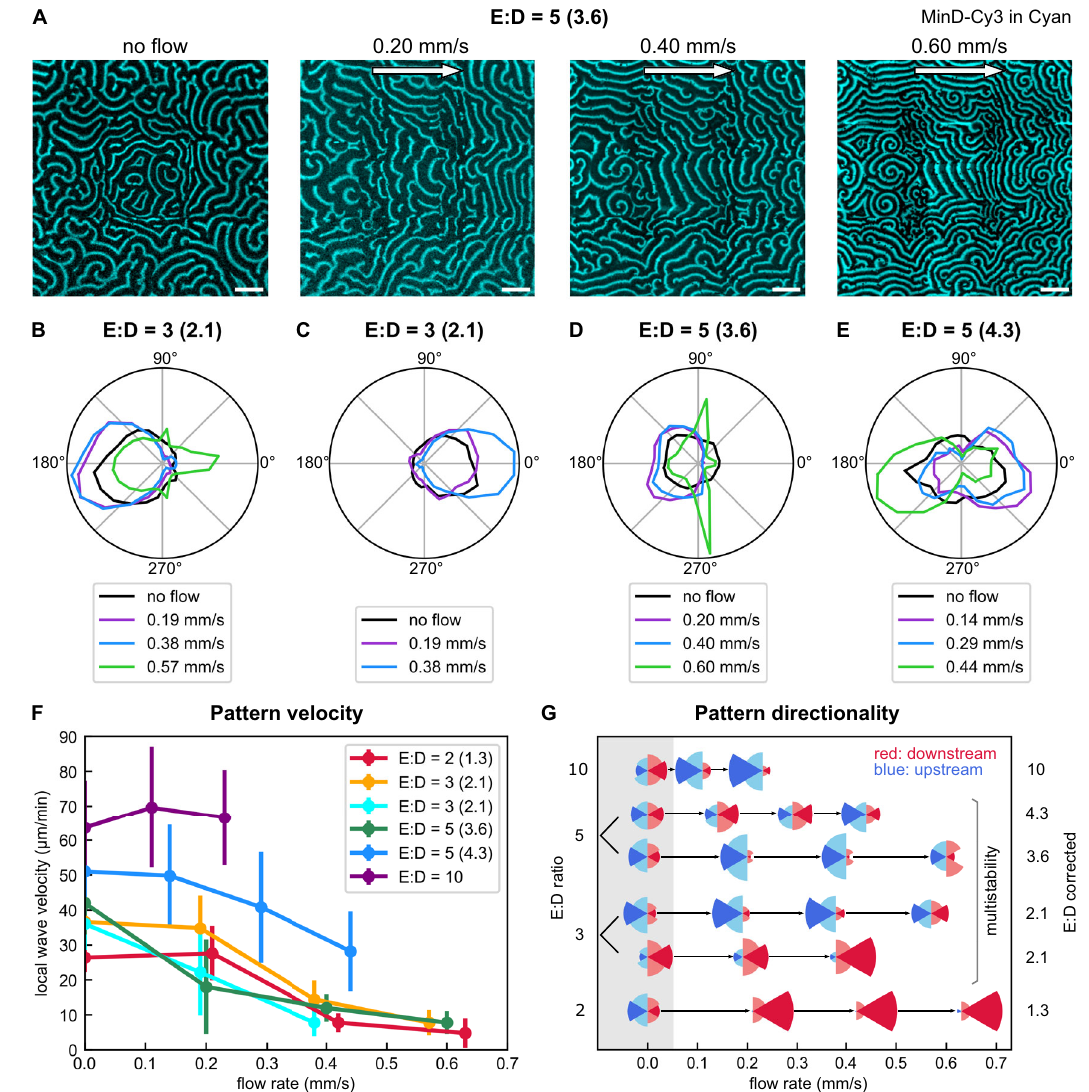
Fig. 4 |Experimentaldatashowing howMinpatternsrespondto asequenceof fl ow rates. A Min patterns for different fl ow velocities at initial ratio E:D=5 (cor- rected 3.6) sampled at the same location within the fl ow channel. Channel MinD- Cy3 in cyan, scale bars 100 μ m. Images stitched from 3×3 fi elds of view. B Polar histogram showing counts per angular segment for initial ratio E:D=3 (corrected 2.1). C Idem for initial ratio E:D=3 (corrected 2.1). D Idem for initial ratio E:D=5 (corrected 3.6). E Idem for initial ratio E:D=5 (corrected 4.3). F Peak velocity